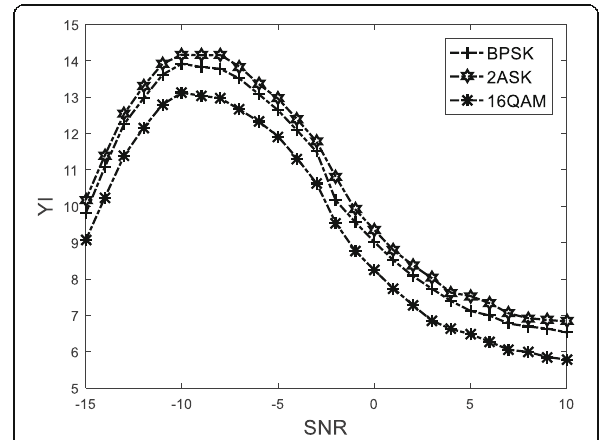
Fig. 12 The change curve of YI with SNR growth